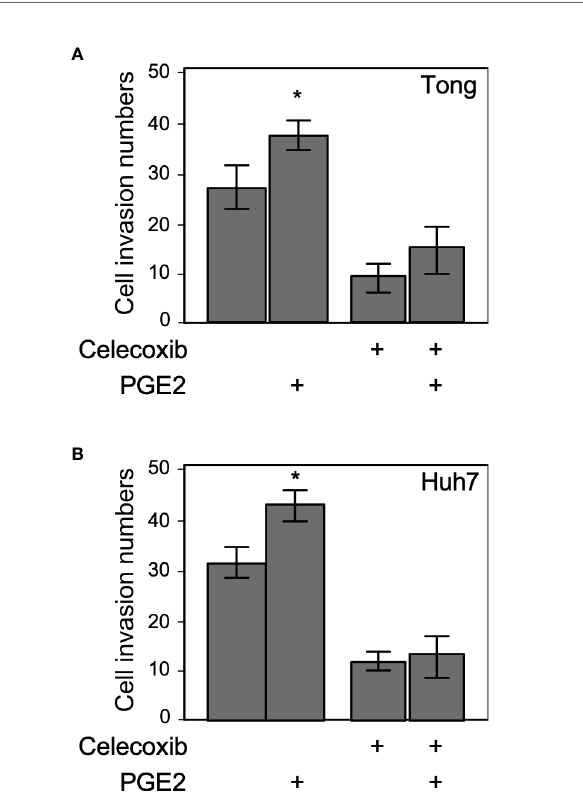
FIGURE 3 | Suppression of invasion by metronomic Celecoxib treatments is a PGE2-independent event. (A) The cell invasion capacity of the Tong cells increased slightly by supra-physiological doses of PGE2 treatments (1 m M; lane 1 vs. 2). However, PGE2 co-treated with metronomic Celecoxib (4 m M, 7 days) did not reverse the Celecoxib suppression effect on cell invasion. (B) The cell invasion capacity of the Huh7 cells was increased by PGE2 treatments (1 m M; lane 1 vs. 2). However, PGE2 and metronomic Celecoxib cotreatment did not reverse Celecoxib-mediated suppression effect on cell invasion. The data were from at least three reproducible independent experiments in which the raw invasive cell number was counted, and mean values with standard errors were plotted on the graph. * Indicates P <